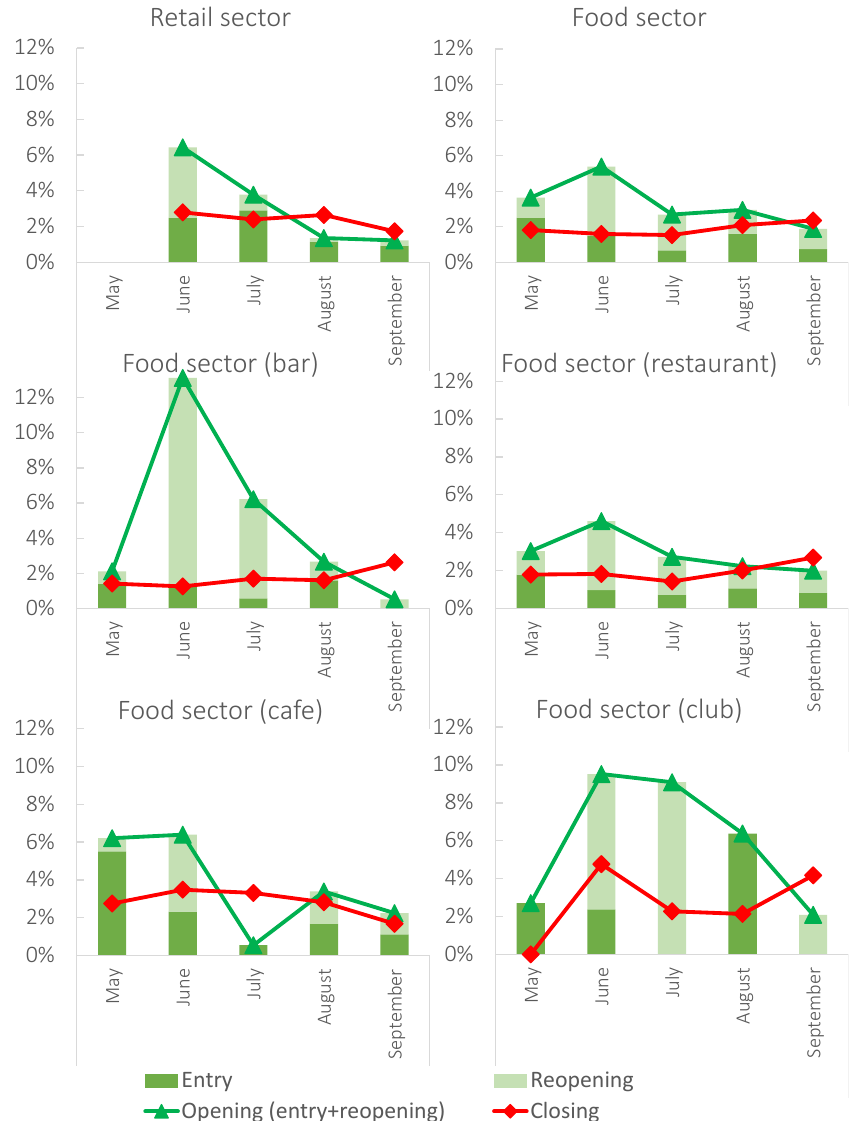
Figure 2. Business opening and closure rates in 2021. Note: The monthly opening and closure rates for the core downtown of Ottawa/Gatineau are derived from Google Places. The food sector is the aggregation of the results by the keywords bar , cafe , restaurant and night_club